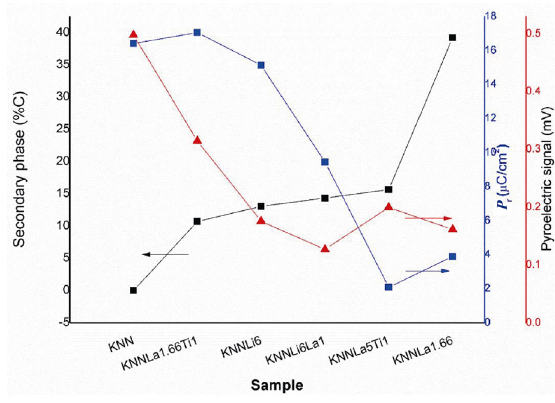
Fig. 8 Comparison of the amount of secondary phase